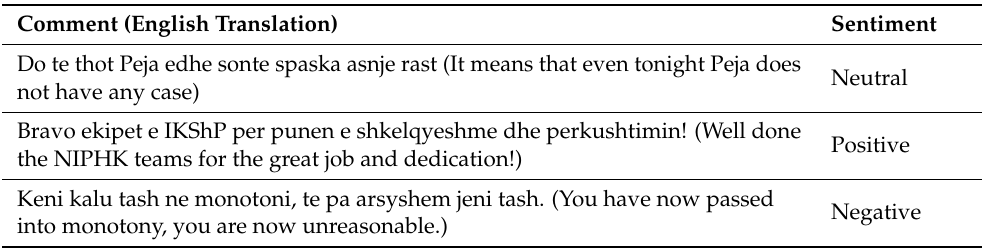
Table 2. Examples of comments annotated with a perfect agreement among